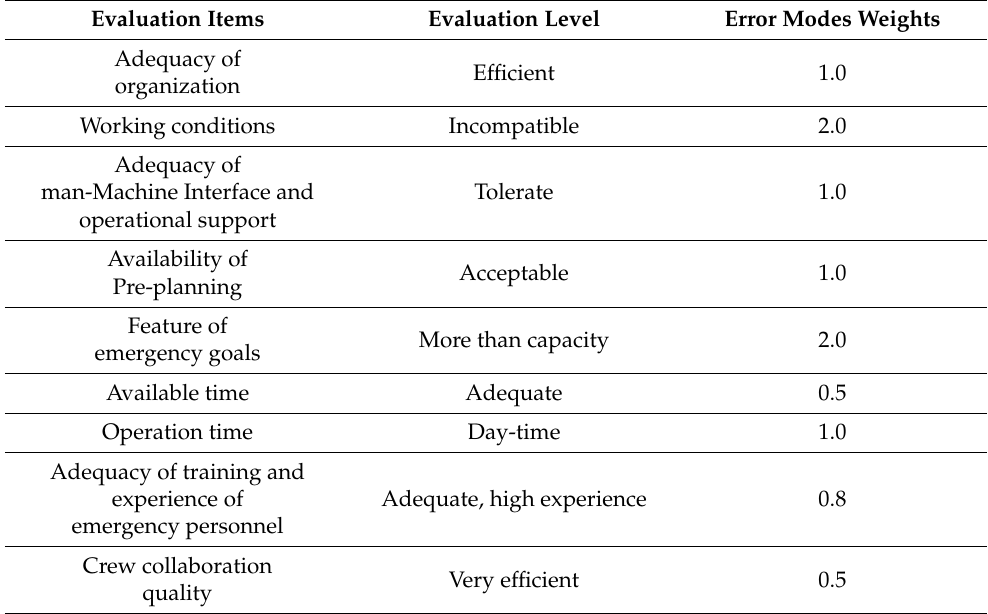
Table 7. Determination of weighting factor for initial handling of accidents.